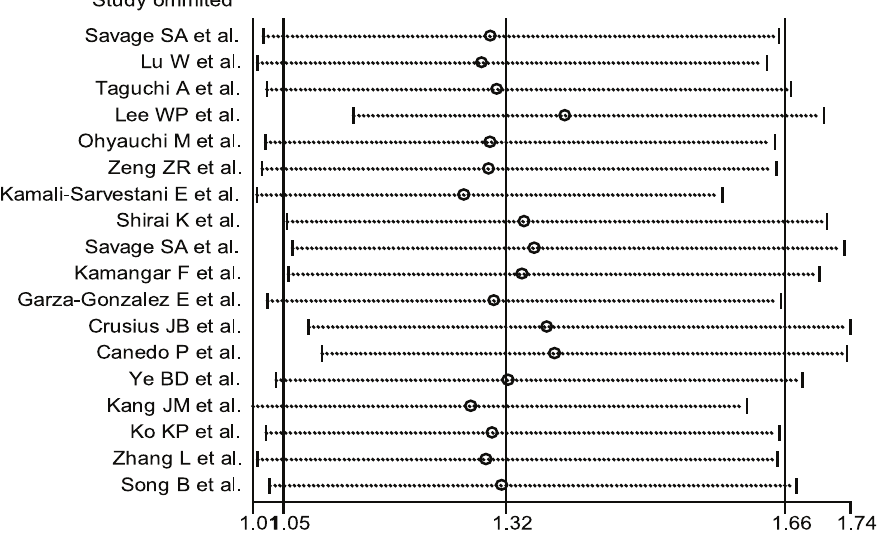
Figure 5. Influence analysis of the summary odds ratio coefficients on the association for the IL-8 -251 AA genotype with gastric cancer risk. Results were computed by omitting each study (on the left) in turn. Bars, 95% confidence interval. Meta-analysis random-effects estimates (exponential form) were used.